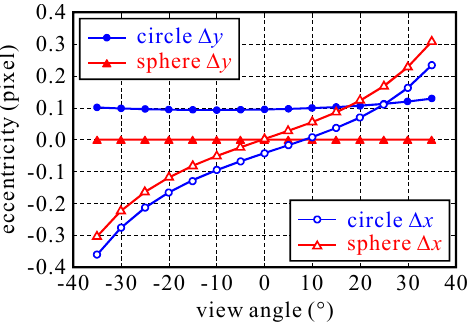
Figure 5. Eccentricity vs. view angle at P4